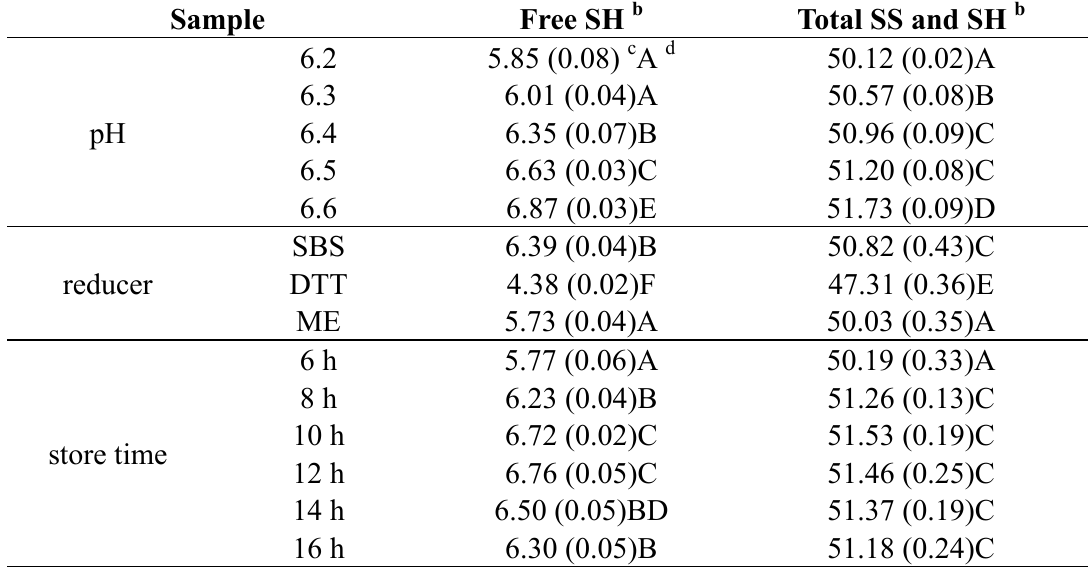
Table 1. Sulfhydryl and disulfide content of proteins a